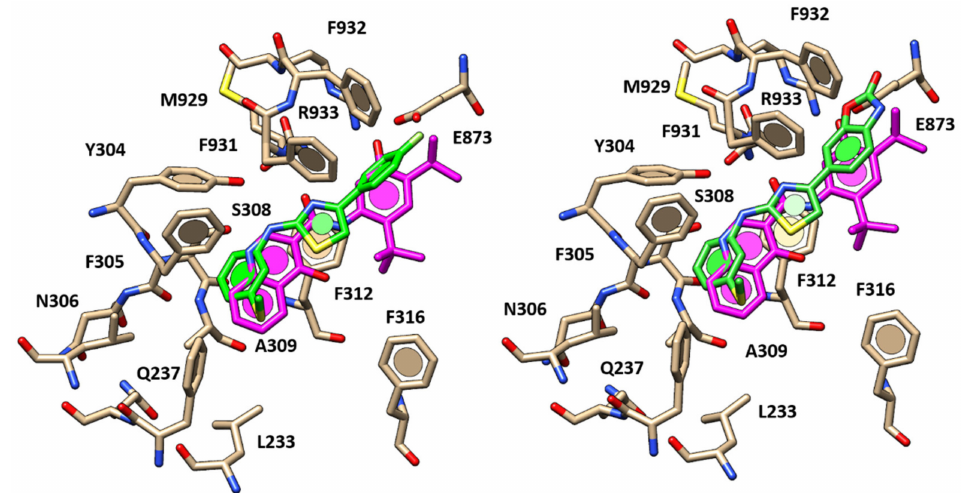
Figure 11. Docking positioning of compound 82 ( Left ) and 84 ( Right ) within the X-ray crystallographic structure of the human CFTR in the presence of the docked VX-770 ( C atom; magenta). Both the two aminoarylthiazoles (AATs) re shown in stick, C atom in green.